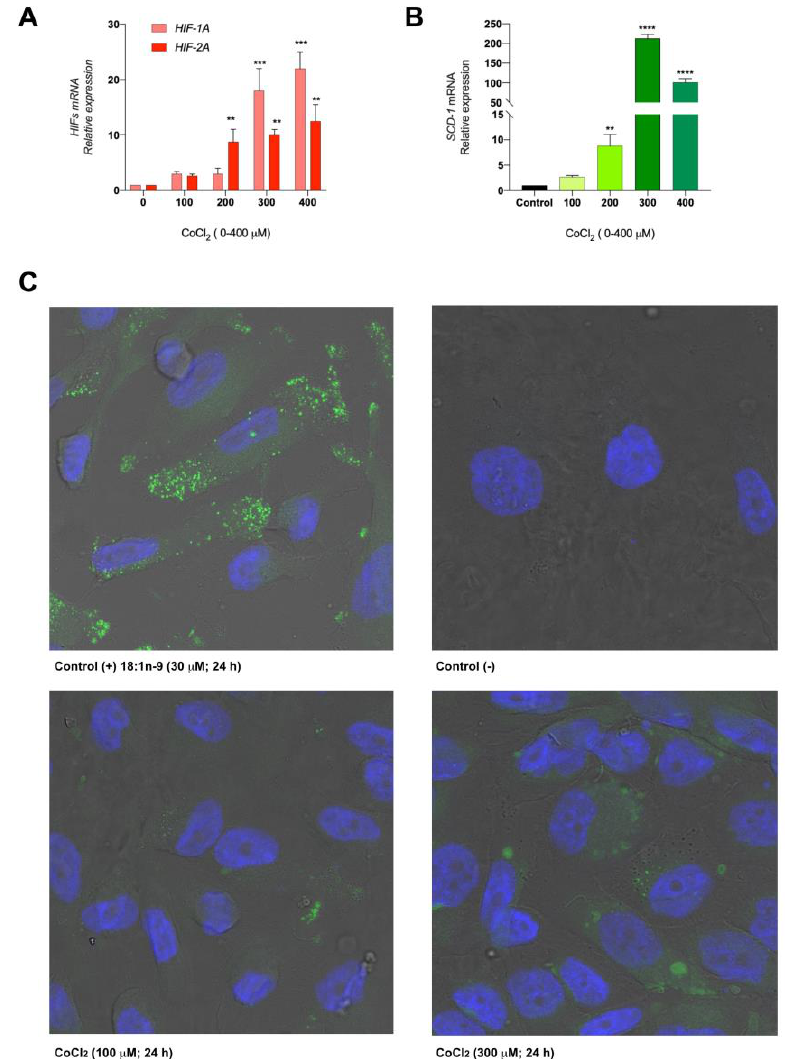
Figure 3. Chemical hypoxia promotes SCD-1 expression in vitro. ( A ) Caki-2 cells were exposed to different concentrations of CoCl 2 (0–400 µM) for 24 h, and the development of the hypoxic microenvironment was tested with the expression of HIF-1A and HIF-2A by RT-qPCR. ( B ) Then, SCD-1 overexpression was detected under the same experimental conditions by RT-qPCR. ( C ) The evaluation of LD formation was determined by confocal microscopy. Caki-2 cells were exposed to 18:1 n -9 (30 µM) for 24 h as a positive control for LD formation. Magnification 400×. Data are expressed as the means ± SEM and are representative of three independent experiments. ** p < 0.01, *** p < 0.001 and **** p < 0.0001, significantly different from the control.